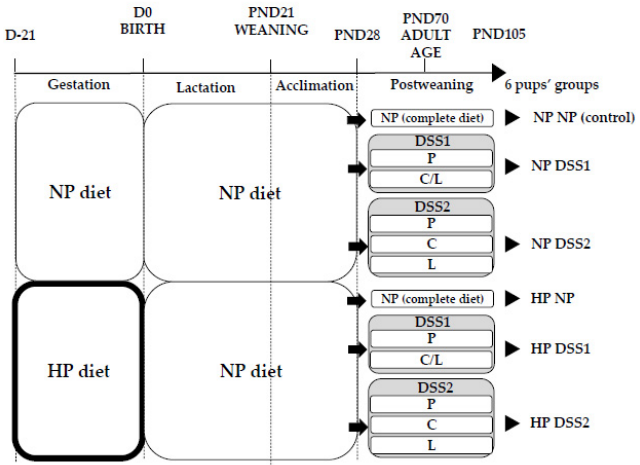
Figure 1. Six experimental groups formed. Dams received a NP control diet or a HP diet during gestation only. From PND28 until PND105, pups were divided into 3 groups from each dam group: NP diet (control, no free choices), DSS1 with P and G/L in 2 different cups and DSS2 with P, G and L in 3 different cups. D, Day; PND, Post-Natal Day; NP, Normal-Protein (control); HP, High-Protein; DSS, Dietary Self-Selection; P, Proteins; C/L, Carbohydrates and Lipids mix; C, Carbohydrates; L, Lipids.